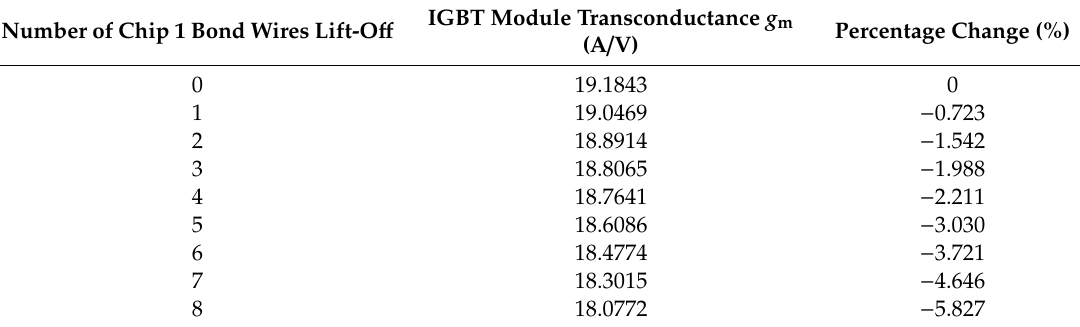
Figure 9. Transmission characteristic curves of Chip 1 under bond wire failure states. Table 5. Module transconductance under bond wire failure states of Chip 1.